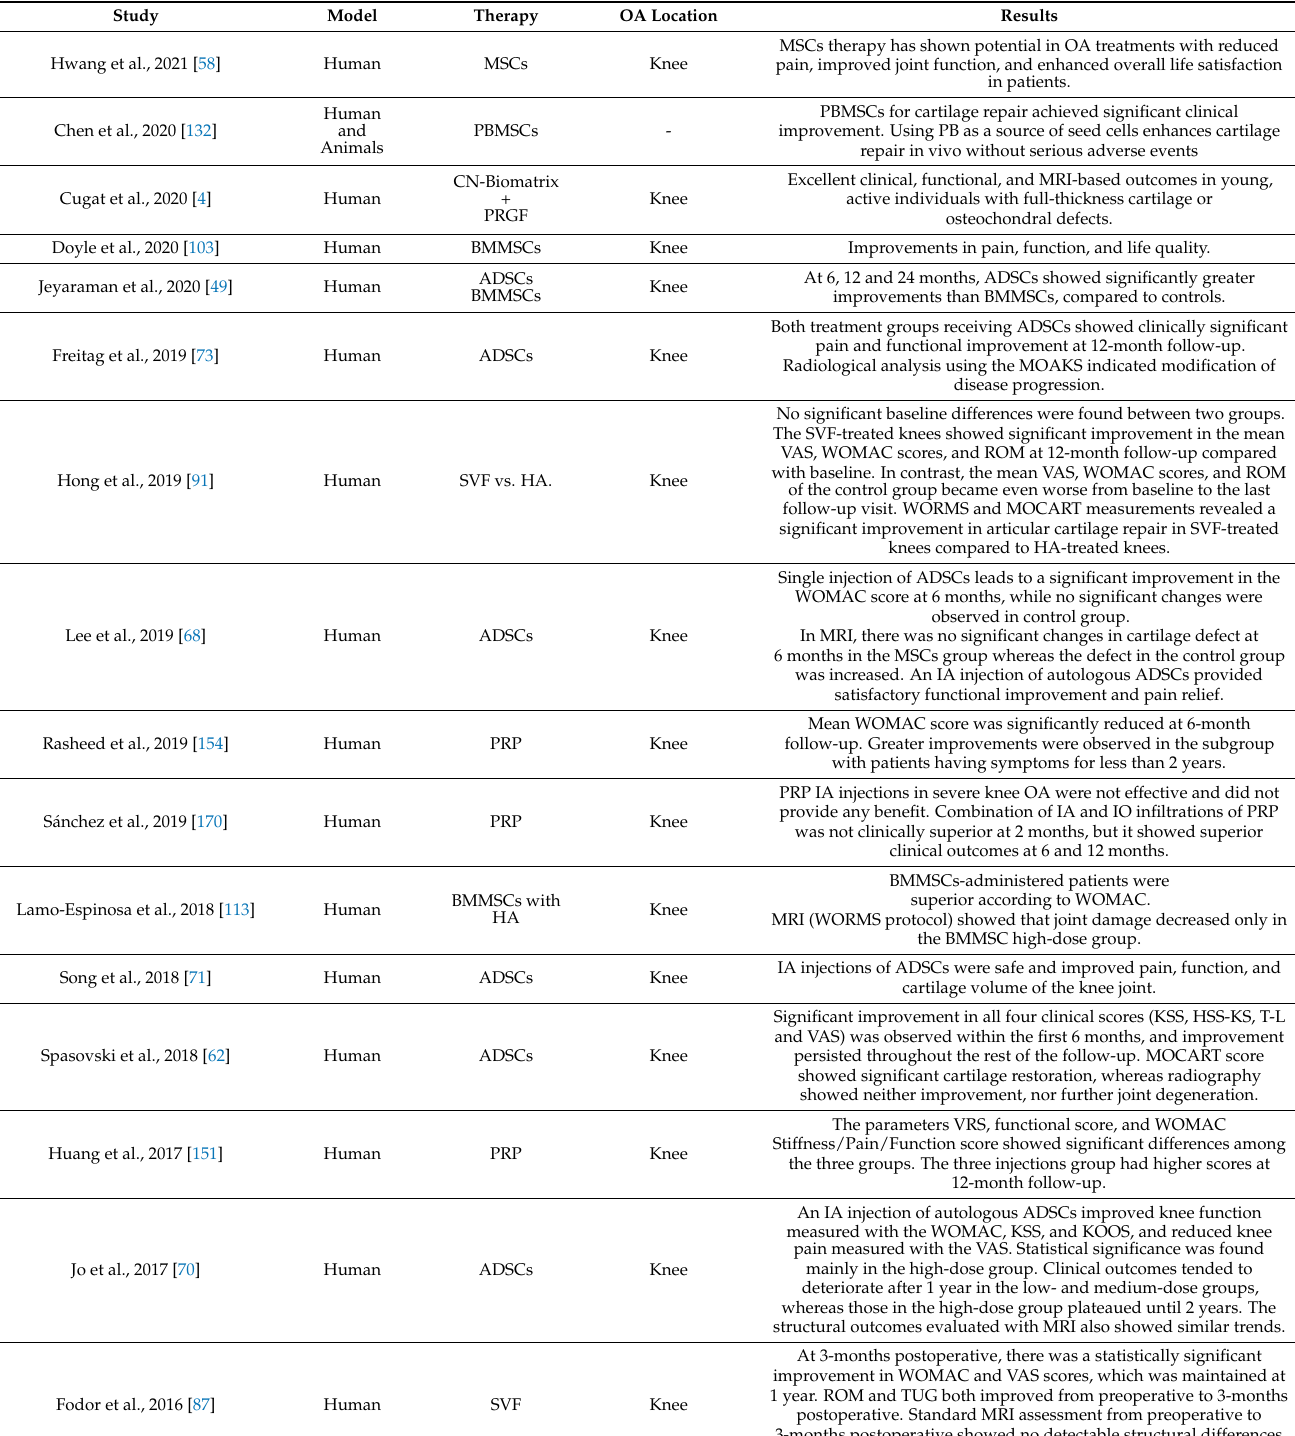
Table 1. Research on osteoarthritis with MSCs and PRP-based therapy. Clinical